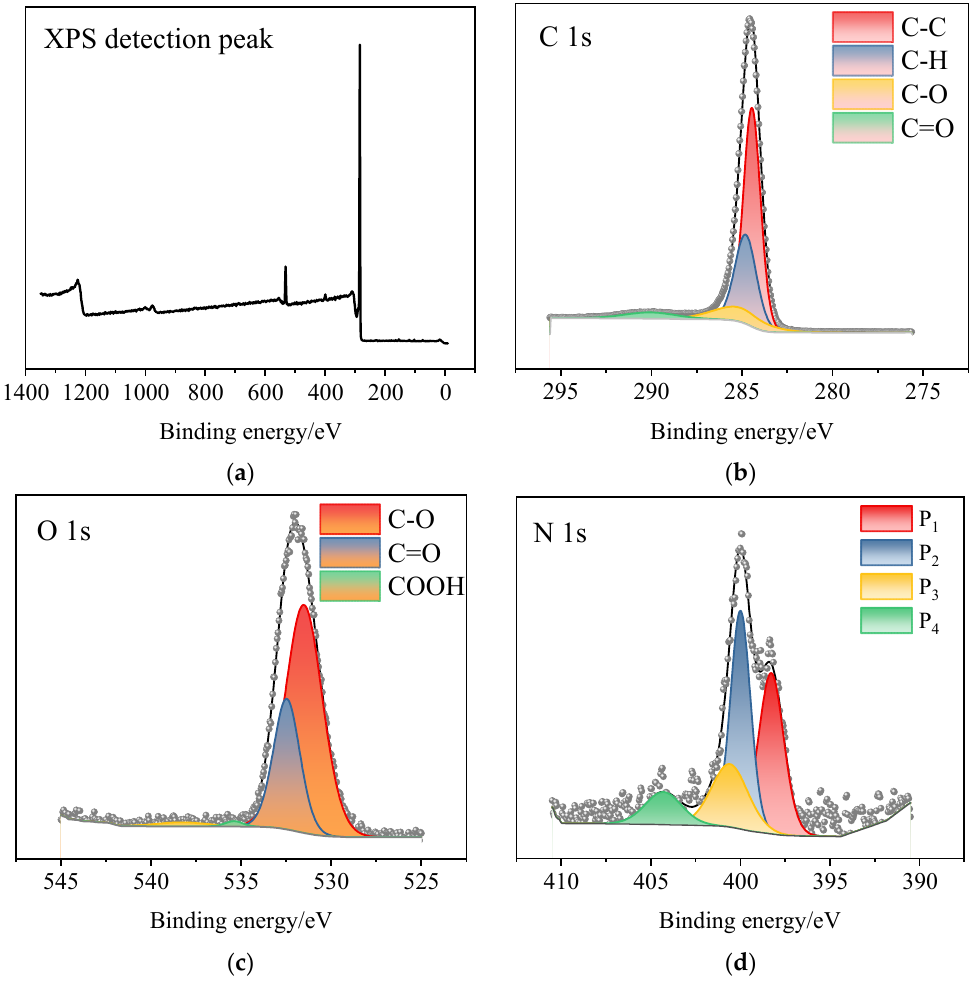
Figure 4. Peaking fitting spectra of gas coal X-ray photoelectron spectroscopy: ( a ) XPS detection spectrum,( b ) C split-peak fitting spectra,( c ) O split-peak fitting spectra,( d ) N split-peak fitting spectra.